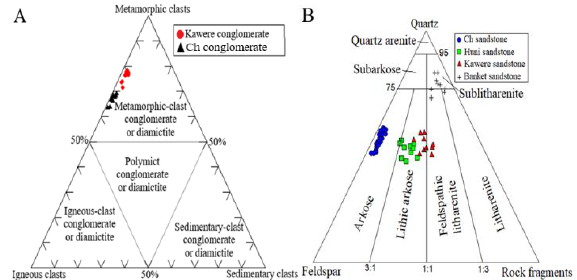
Figure 3: (A) Classification of the conglomerates based on pebble composition (Boggs, 1992), (B) Classification of the sandstones using QFR ternary plot (Folk, 1974): Quartz (Q) (mono and polycrystalline quartz without chert), Rock fragments (R) including chert. Classification of the Chagupana, Huni, Kawere and Banket sandstones (Figure 3B) are; arkose, lithic arkose, lithic arkose-feldspathic litharenite, and predominantly sublitharenite, respectively (Folk,